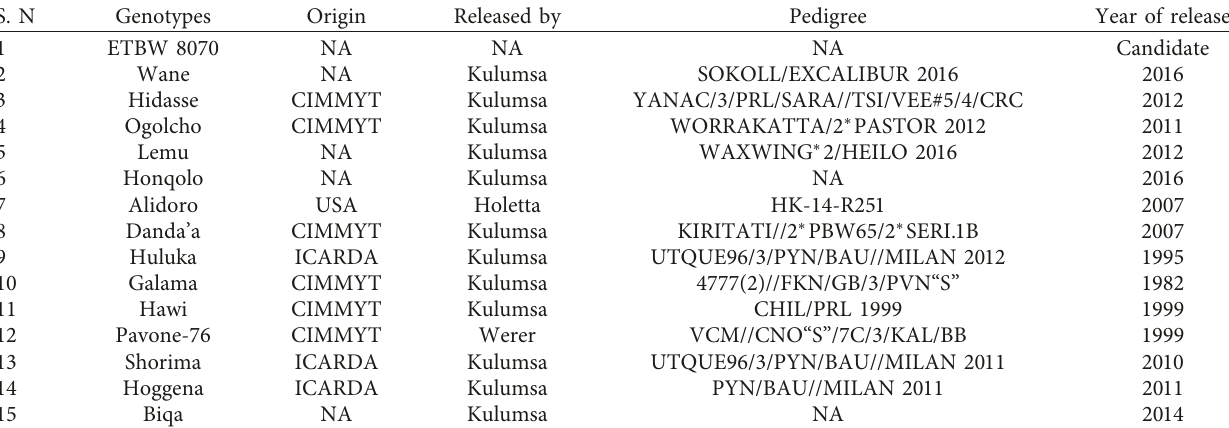
Table 2: Details of bread wheat genotypes used in the field